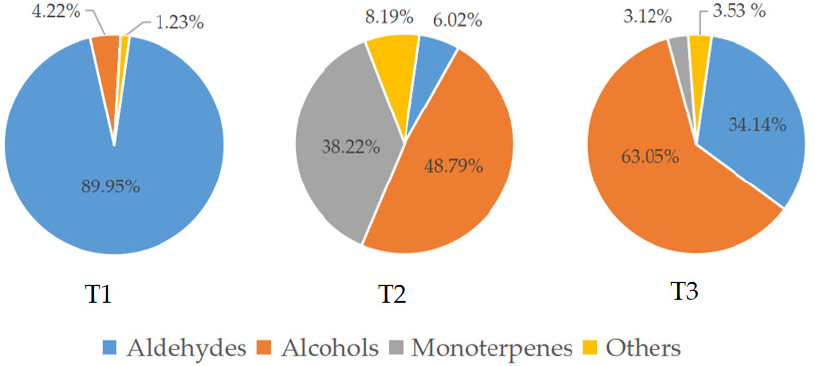
Figure 2. Relative content of volatile categories of L. caudata in three flowering stages. T1: pre- blooming stage; T2: full-blooming stage; T3: over-blooming stage.